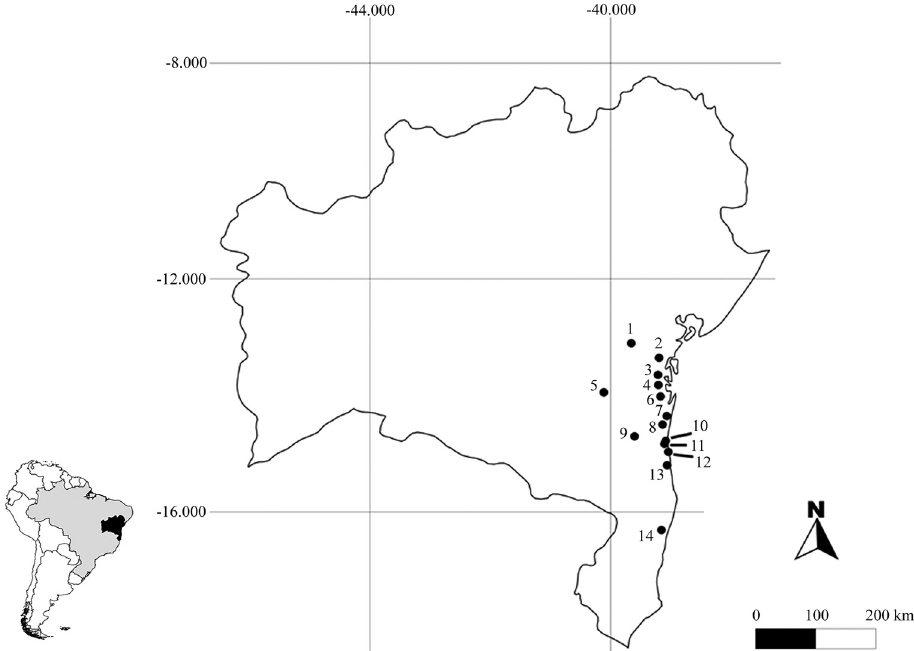
Figure 1 - Geographical location of sampling sites. 1 – Amargosa, 2 – Valença, 3 – Nilo Peçanha, 4 – Reserva Ecológica da Michelin - Igrapiúna, 5 – Jequié, 6 – Camamu, 7 – RPPN Capitão - Itacaré, 8 – Parque Estadual da Serra do Conduru - Uruçuca, 9 – Almadina, 10 –Parque Municipal da